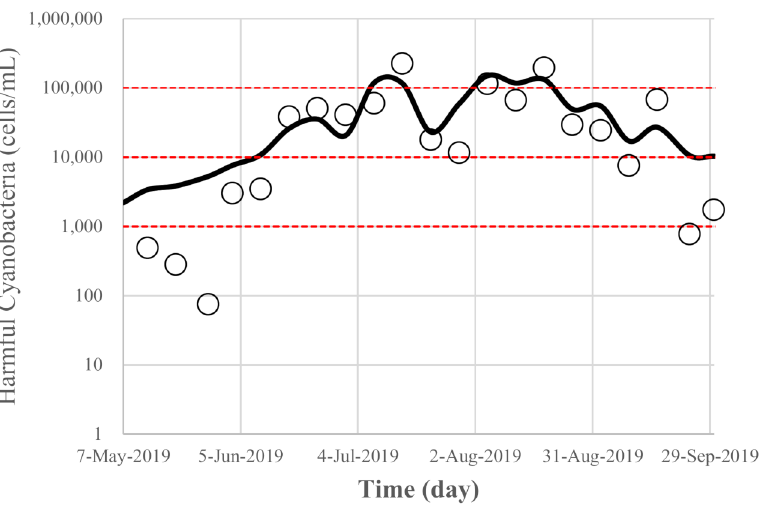
Figure 8. Simulated harmful cyanobacteria values compared with harmful cyanobacteria measured at a point 500 m upstream from the Changnyeong-Haman